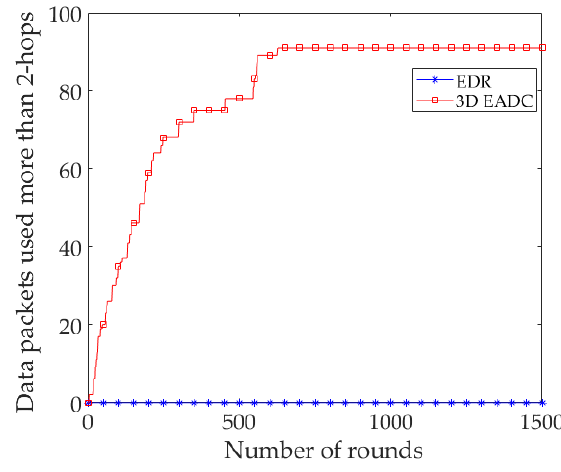
Figure 7. Data packets received at the sink used 3-hops.